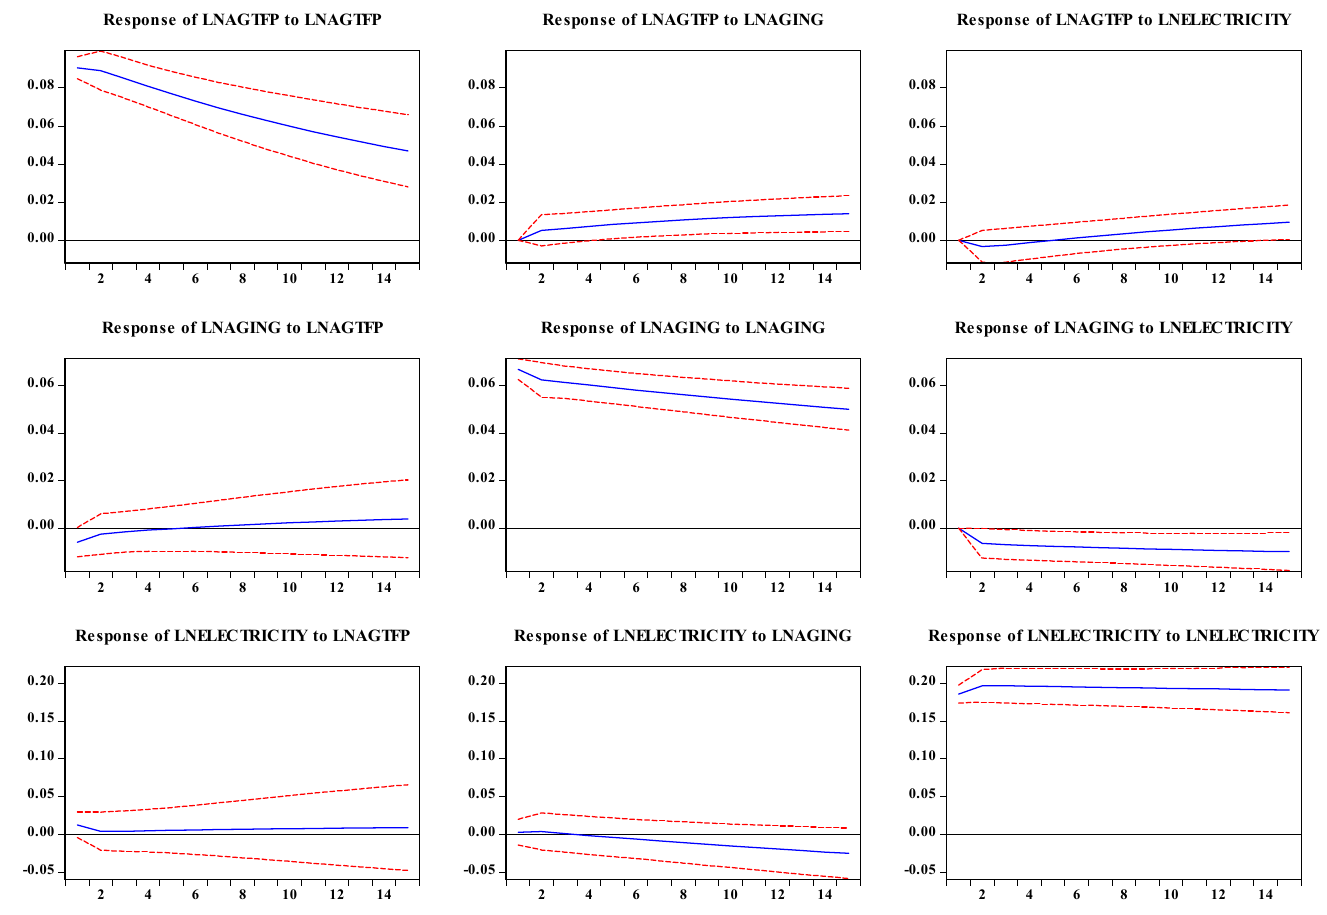
Figure 5. Impulse responses of LNAGTFP, LNAGING and LNELECTRICITY, used to predict 15 years (blue), with a confidence interval of 95% (red).